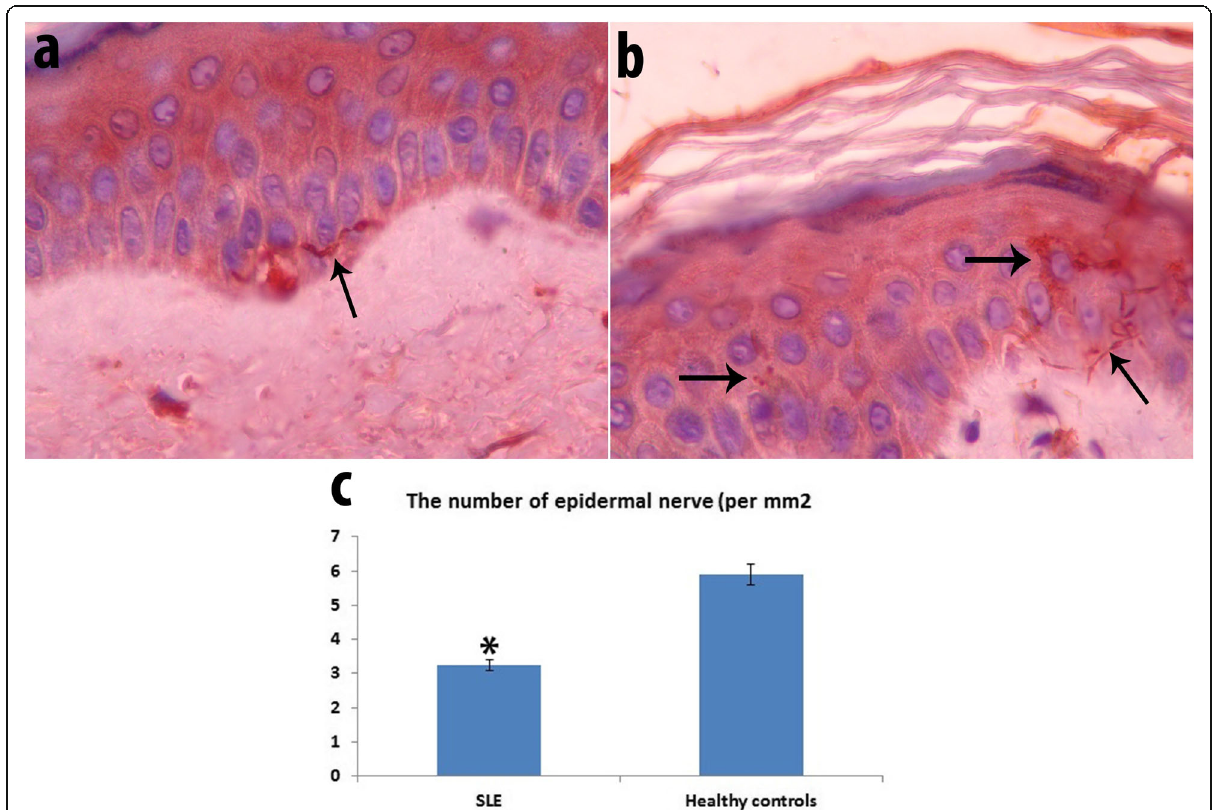
Fig. 1 The epidermal nerve density in SLE patients and controls. a SLE, b Controls, c Bar